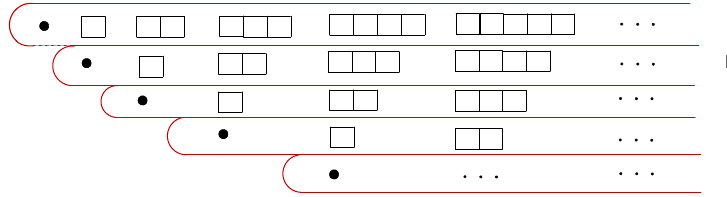
Figure 8 . The so (1 ; 1)-covariant basis of hs [ (cid:21) ] in the twisted form. Each Young diagram of length k is a rank- k irreducible so (1 ; 1)-module d k . Subspaces